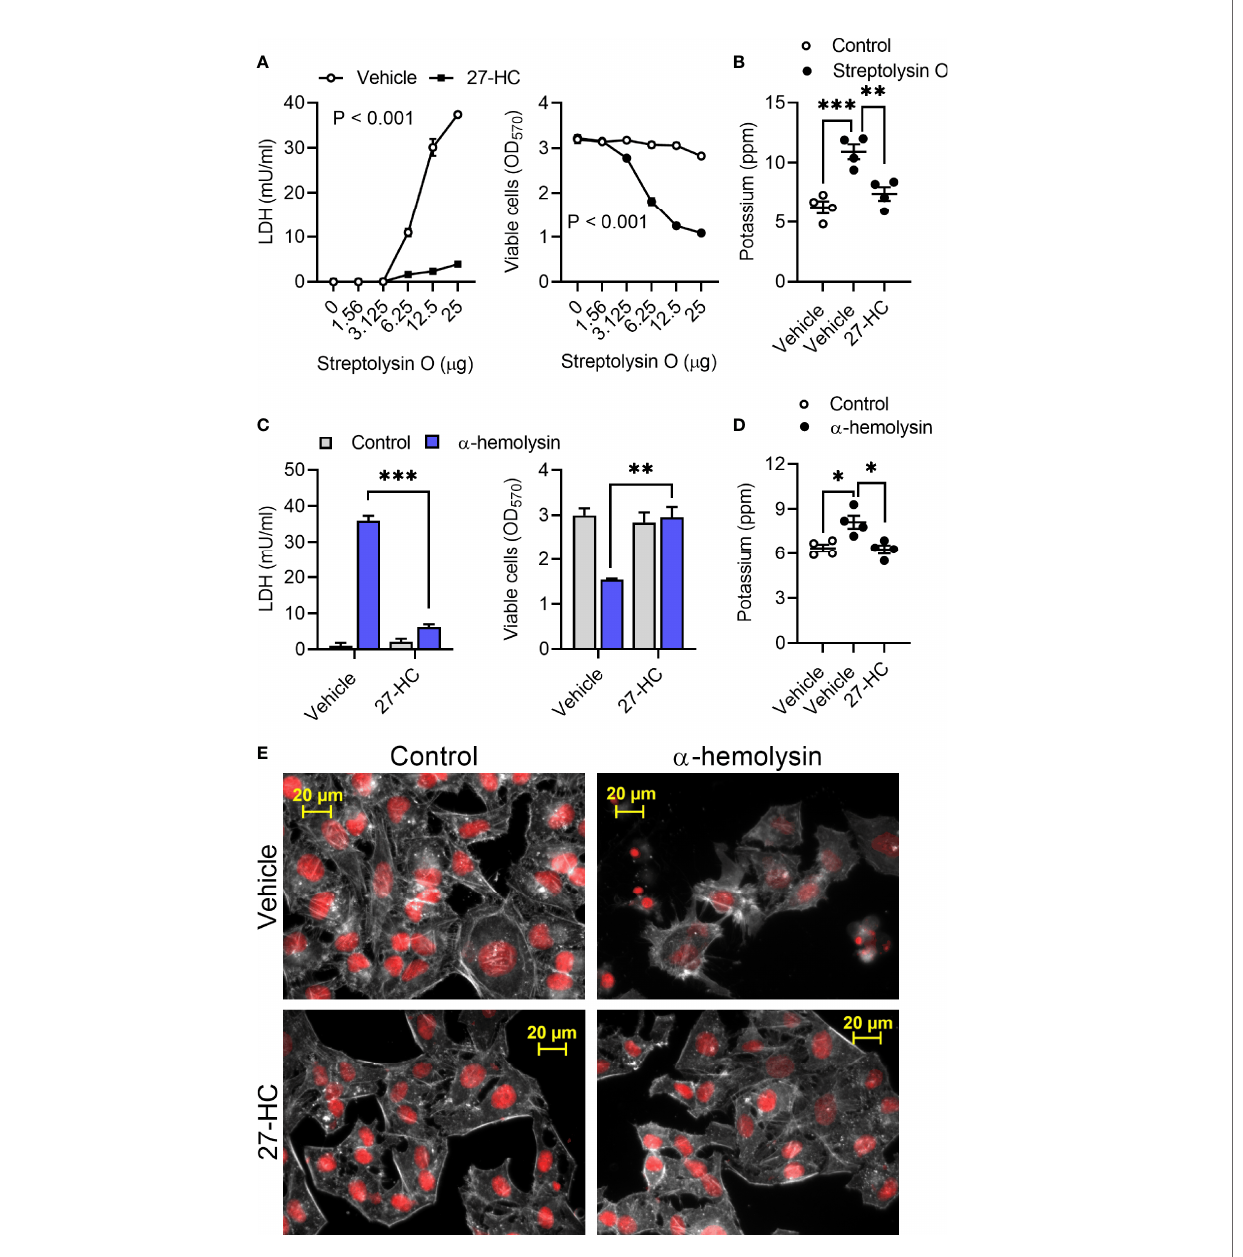
FIGURE 4 | 27- hydroxycholesterol protects cells against streptolysin O and a -hemolysin. (A) HeLa cells were cultured for 24 h in serum-free medium with vehicle ( ○ ) or 25 ng/ml 27-hydroxycholesterol (27-HC, ● ), and then challenged for 24 h with the indicated concentrations of streptolysin O. The leakage of LDH was measured in cell supernatants and viable cells were determined by MTT assay. Data are presented as mean ± s.e.m. from 4 independent experiments. Data were analyzed by ANOVA. (B) The leakage of potassium from HeLa cells cultured for 24 h in serum-free medium with vehicle or 25 ng/ml 27-HC, and then challenged for 5 min with control serum-free medium ( ○ ) or streptolysin O ( ● ). Extracellular potassium was measured in supernatants by fl ame photometry. Data are presented as mean ± s.e.m. with dots representing the values from 4 independent experiments. Data were analyzed by ANOVA with Dunnett ’ s post hoc test, ***P < 0.001, **P < 0.01. (C) HeLa cells were cultured for 24 h in serum-free medium with vehicle or 25 ng/ml 27-HC, and then challenged for 24 h with control medium ( ■ ) or 8 µg/well a -hemolysin ( ■ ). The leakage of LDH was measured in cell supernatants and viable cells were determined by MTT assay. Data were analyzed by ANOVA with Tukey ’ s post hoc test, ***P < 0.001, **P < 0.01. (D) The leakage of potassium from A549 cells cultured for 24 h in serum-free medium with vehicle or 25 ng/ml 27- HC, and then challenged for 15 min with control serum-free medium ( ○ ) or 8 µg/well a -hemolysin ( ● ). Extracellular potassium was measured in supernatants by fl ame photometry. Data are presented as mean ± s.e.m. with dots representing the values from 4 independent experiments. Data were analyzed by ANOVA with Dunnett ’ s post hoc test, *P < 0.05. (E) Fluorescent microscope images of HeLa cells cultured for 24 h in serum-free medium with vehicle or 10 ng/ml 27-HC, and then challenged for 2 h with control serum-free medium or a -hemolysin. Cells were stained with Alexa Fluor 555-conjugated phalloidin to visualize F-actin (white) and fl uorescent microscope images collected (nuclei are red); images are representative of 3